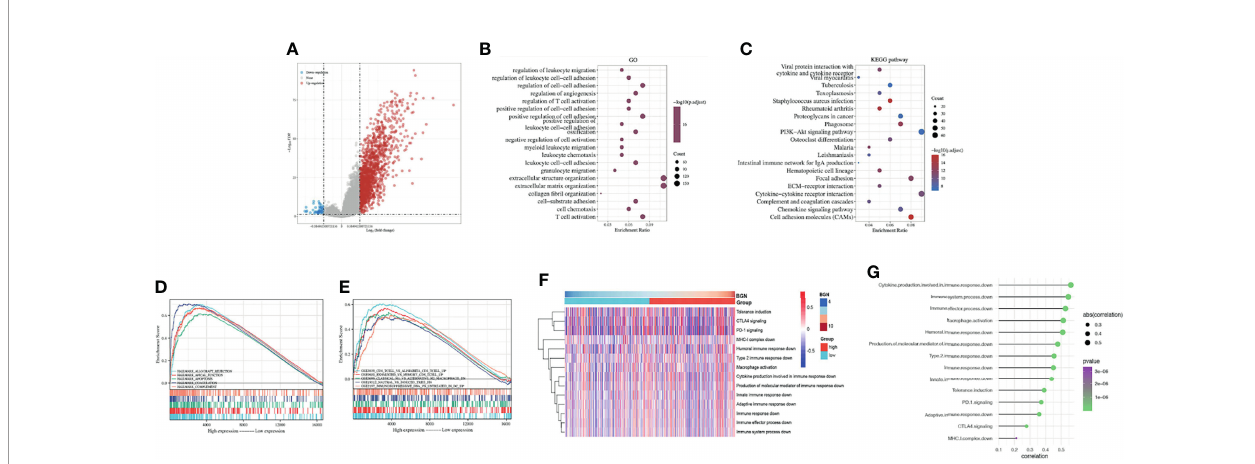
FIGURE 6 | Identi fi cation of the correlation between BGN and the regulation of immune responses in colon cancer. (A) Volcano plot of the DEGs expression between BGN high and low subgroups. The blue and red dots represented the signi fi cantly downregulated and upregulated genes, respectively; The gray dots represented the genes without differential expression. (B, C) GO and KEGG results for differential expression genes. The X-axis represents gene ratio and the Y-axis represents different enriched pathways. (D, E) The enriched gene sets in HALLMARK and C7 collections by samples of DEGs. Each line representing one particular gene set with unique color. Only gene sets with NOM p-value < 0.05 and FDR q-value < 0.05 were considered signi fi cant. (F) Heatmap showing BGN-associated GSVA scores of 14 innate and adaptive immunity-related gene sets. (G) Pearson correlation between the GSVA scores of 14 innate and adaptive immunity-related gene sets and the expression level of BGN in colon cancer.